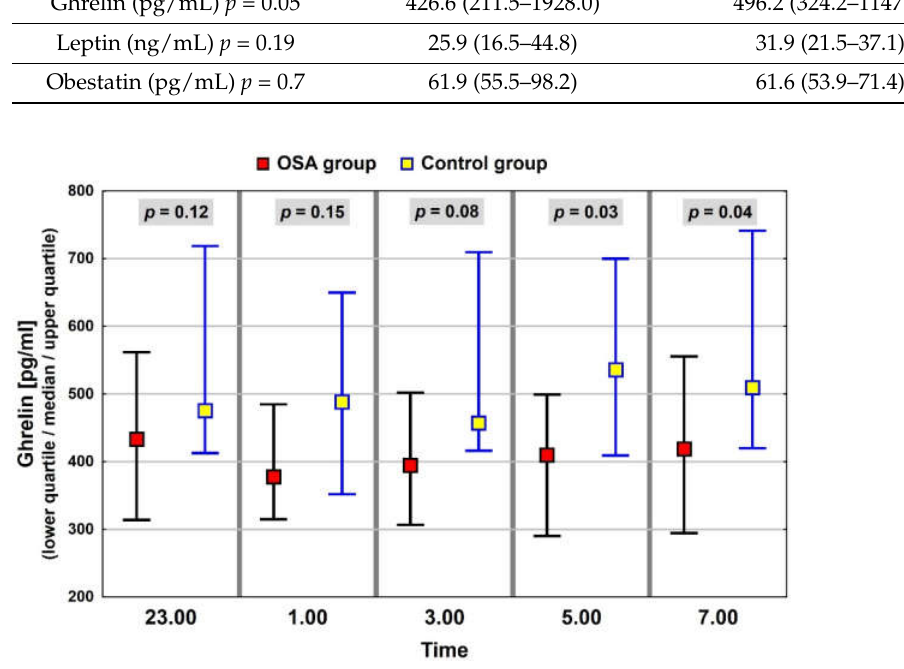
Figure 5. Night ghrelin values in groups of patients with and without OSA. The interquartile range (IQR) of neuropeptide concentrations is marked with black and blue lines.